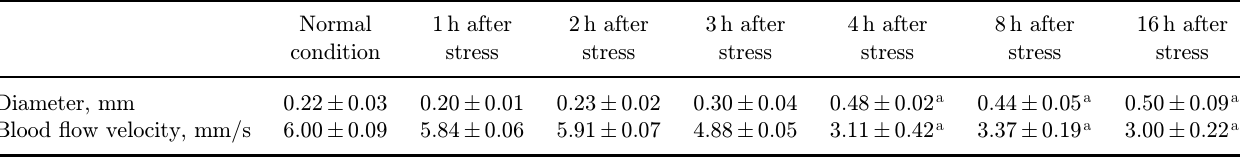
Table 1. The changes in diameter of main trunk sagittal vein and velocity of blood °ow under normal condition, during 12 h after stress on newborn